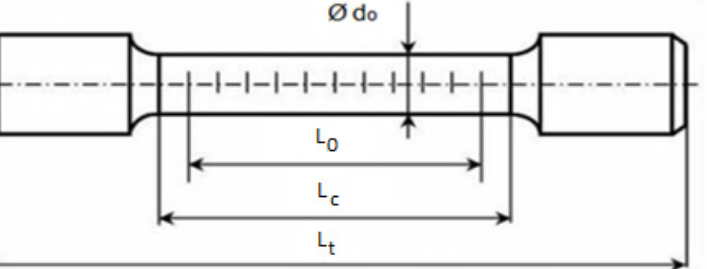
Figure 1. Sample under test and its typical dimensions, Lc is parallel length, L 0 is original gauge length, L t is total length of tested piece, and d 0 is diameter of sample.